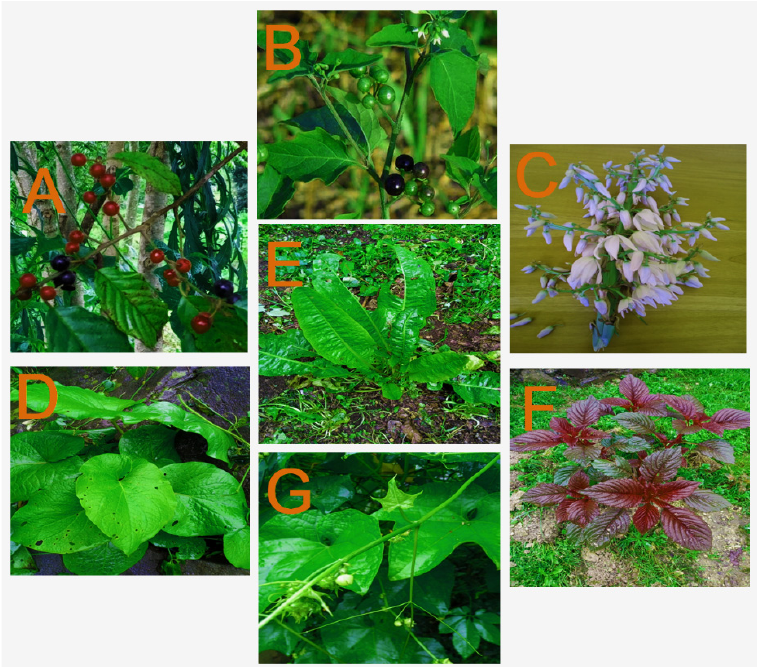
Figure 1. Seven quelites (edible plants) consumed in the northern highlands of Puebla-México grown under open field conditions. ( A ) Tepeilite ( Rhamnus pompana ). ( B ) Hierbamora ( Solanum